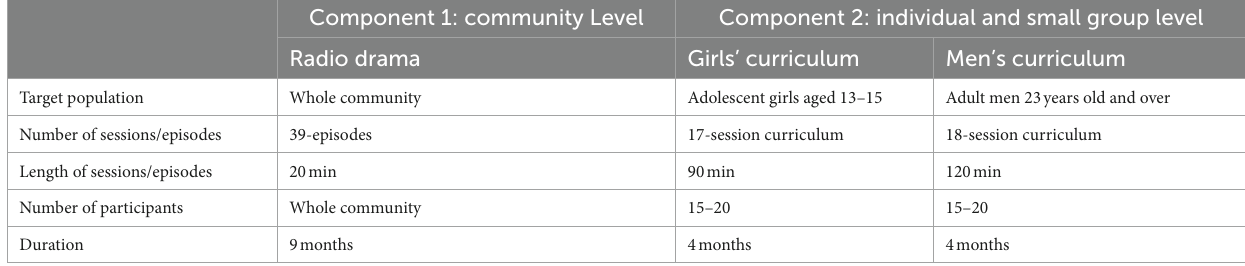
TABLE 2 Learning Initiative on Norms, Exploitation, and Abuse (LINEA) Intervention